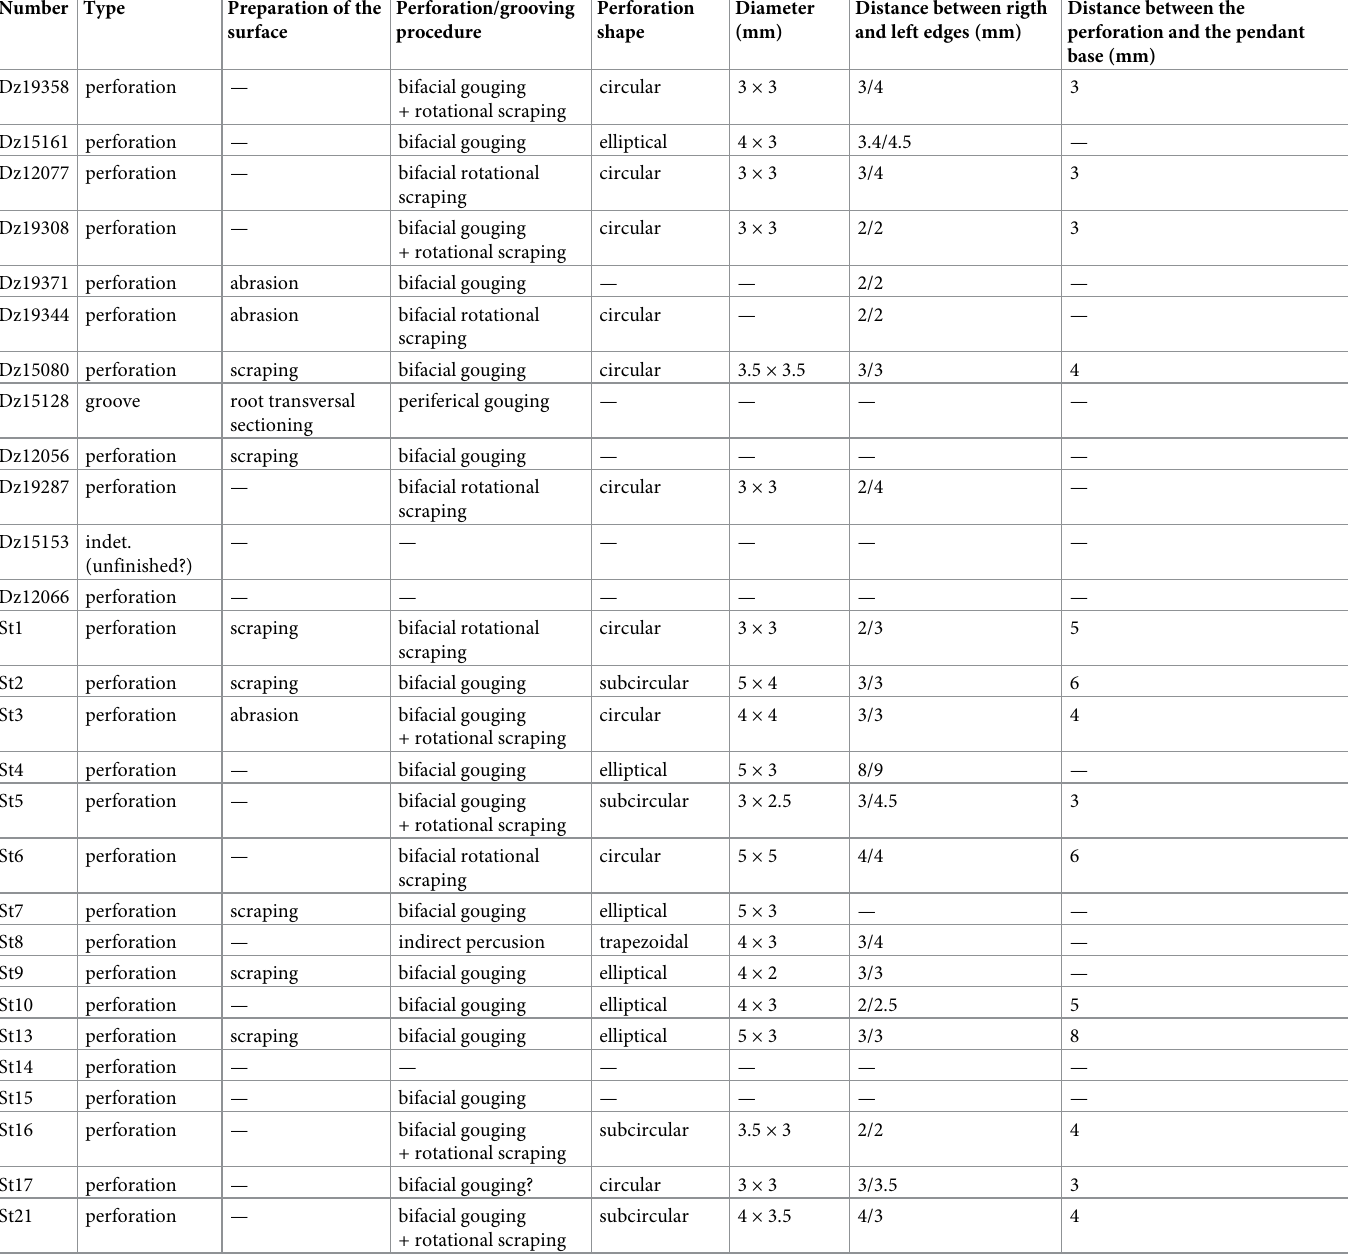
Table 3. Detailed description of the pendants attaching